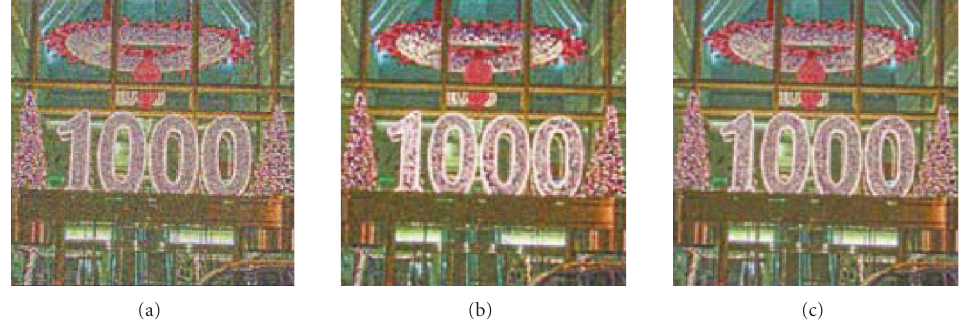
Figure 6: Comparing ROAD filter with our SCT filter on image corrupted by mixed Gaussian ( σ = 10) and impulse noise (15%). (a) Test image, (b) result of ROAD filter (PSNR = 23.35), and (c) result of SCT filter (PSNR =